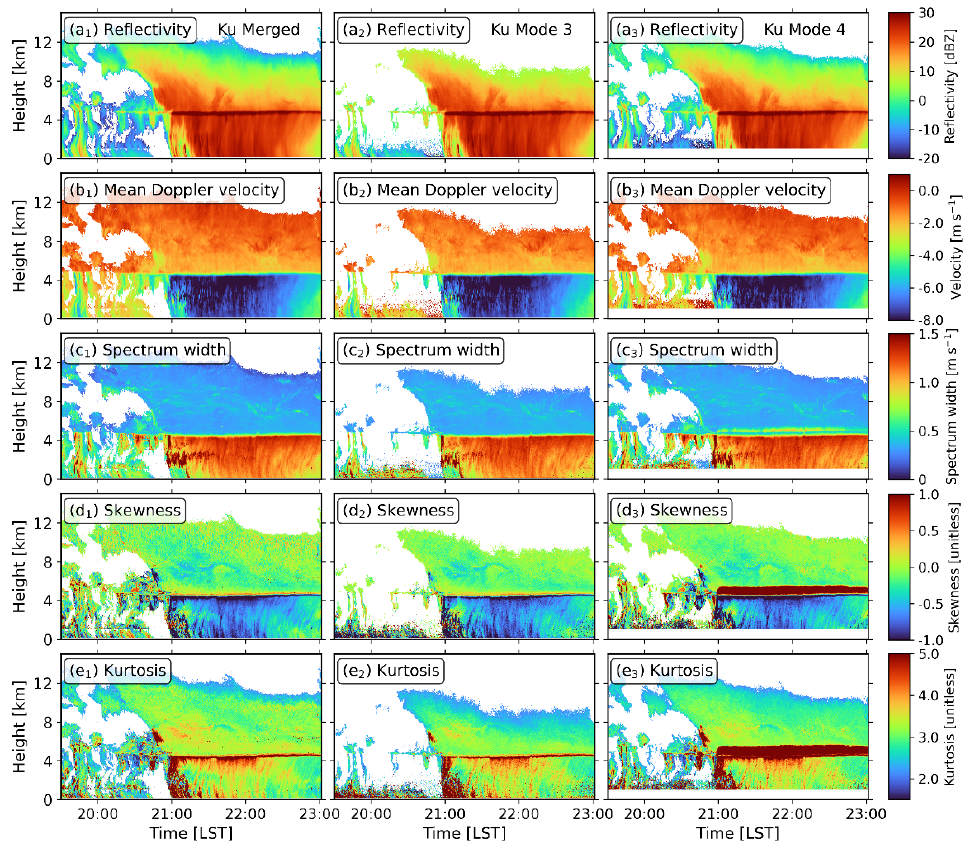
Figure 15. Time–height cross-section plots of Ku-band Doppler spectra moments from 19:30:19 to 23:01:26LST. The left column (a1– e1) is estimated from the merged Doppler spectra, and the middle (a2–e2) and right (a3–e3) columns are from the data recorded at modes 3 and 4, respectively. From top to bottom: (a1–a3) reflectivity; (b1–b3) mean Doppler velocity; (c1–c3) spectrum width; (d1–d3) skewness; (e1–e3)